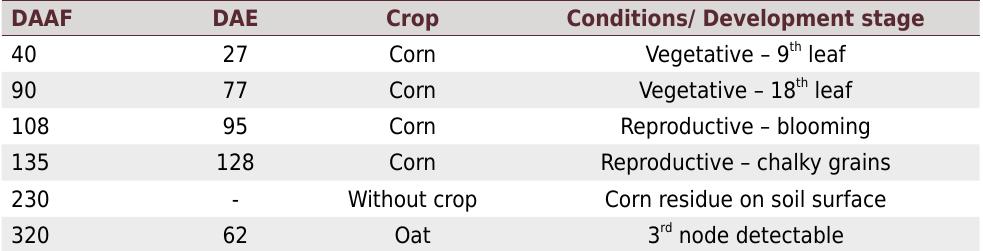
Table 2. Soil solution extraction and analysis dates, represented in days after the application of fertilizers (DAAF) and days after crop emergence (DAE) of each season, and conditions or crop development stage